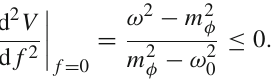
Fig. 7 Top: E /( m φ Q ) vs. Q for ω 0 = 0 (left) and ω 0 = 0 . 99 m φ (right) for the ground state ( N = 0) and several excited states. In the regime with E /( m φ Q ) > 1, the Q-ball can decay into Q free scalars, indicated by the dashed portion. The gray dashed lines denote our ana- lytical large-Q predictions given in Eq. (61) and footnote 2. Bottom: Q